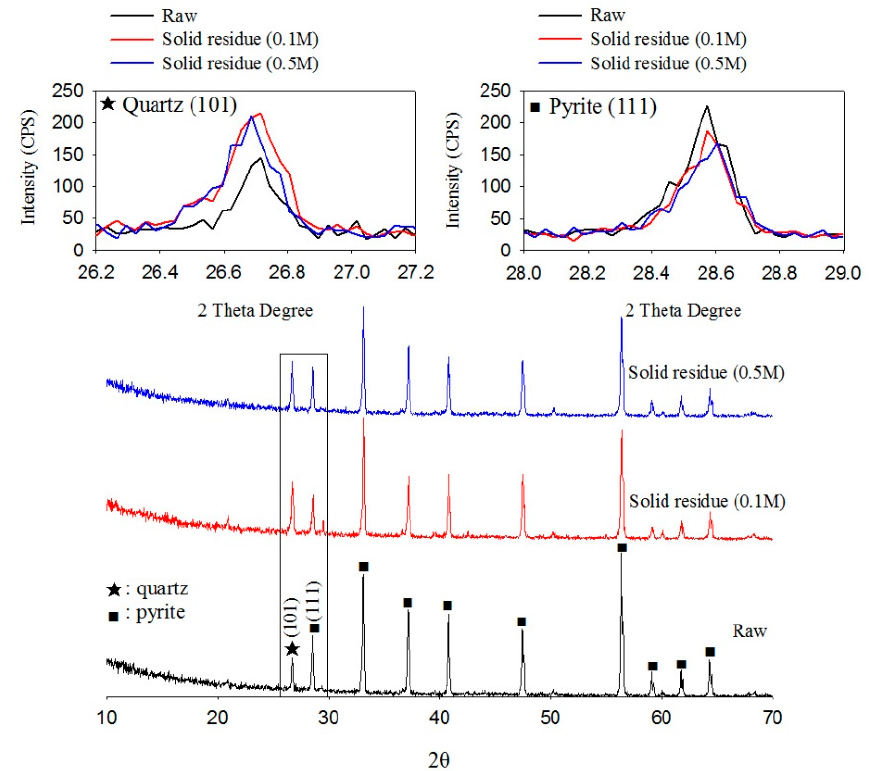
Figure 11. XRD patterns of raw and leach residue from nitric acid leaching at 0.1 and 0.5 M. The leaching conditions were 80 °C and 15 min.